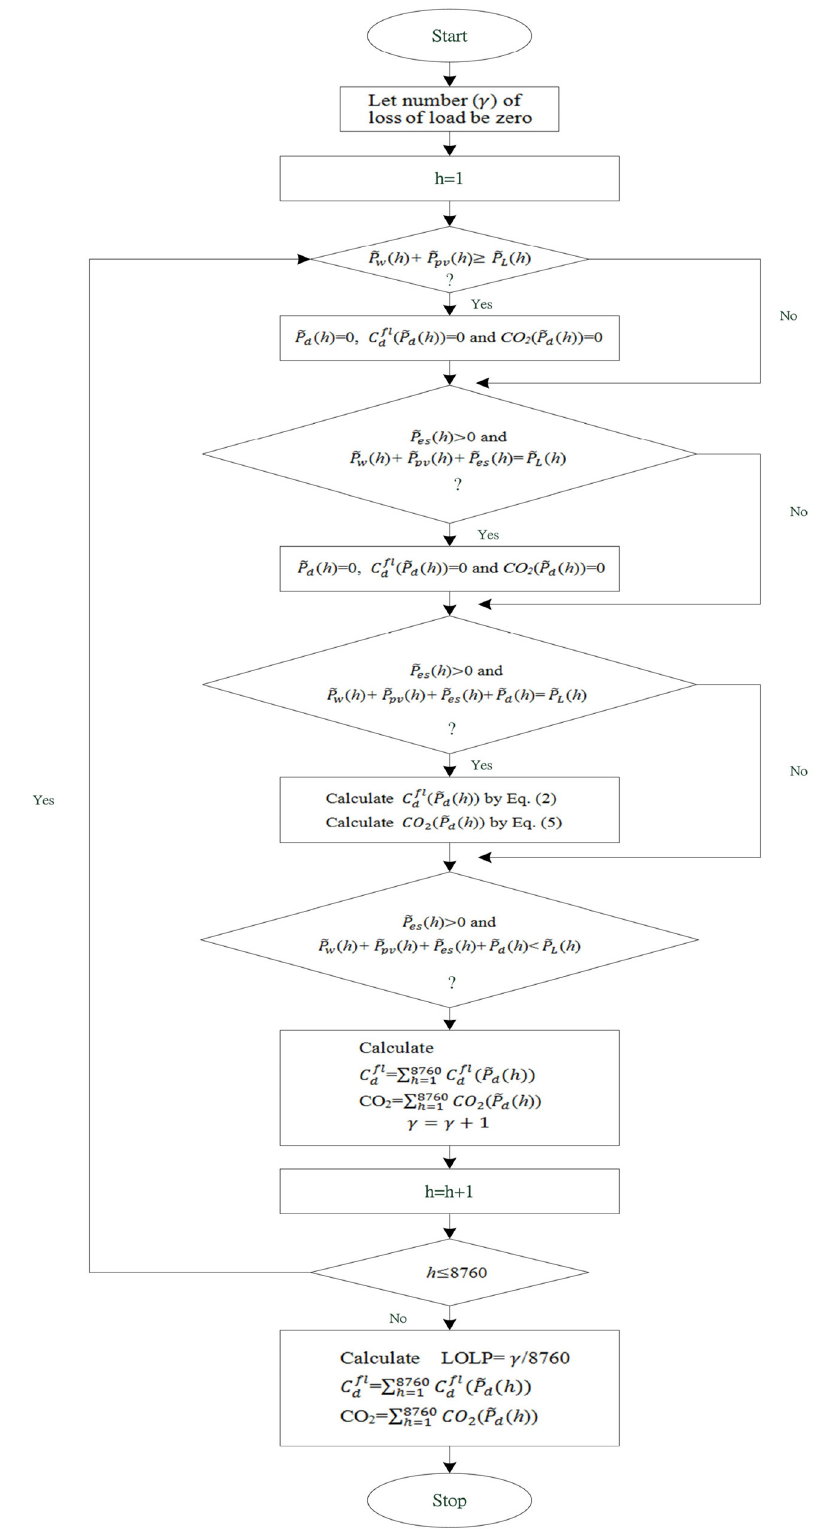
Figure 1. Flowchart of calculating the fuel cost, LOLP and the emission of CO 2